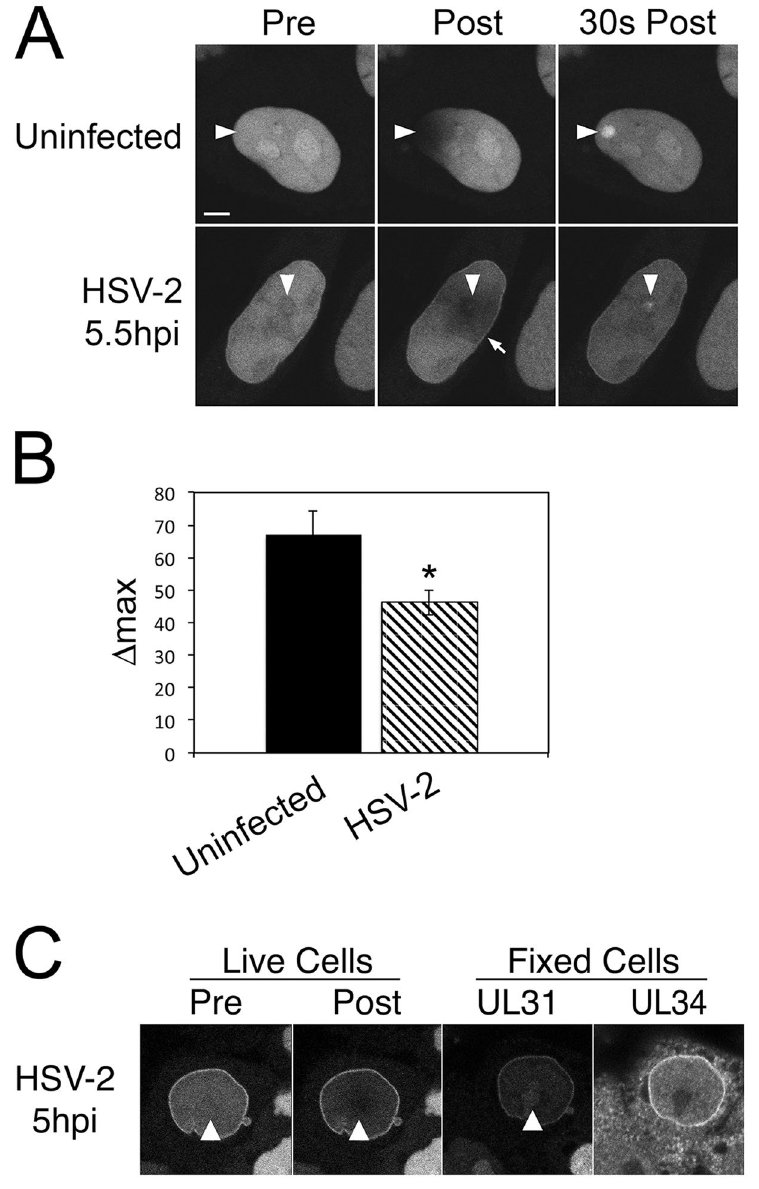
Figure 12. UL31 is preferentially recruited to sites of laser microirradiation in HSV-2 infected cells. ( A ) HeLa/EGFP31 cells were either mock-infected (uninfected) or infected with HSV-2 at an MOI of 3 for 5.5 h prior to microirradiation and time lapse analysis. Representative images from time lapse experiments before irradiation (Pre), immediately after irradiation (Post) and 30 s post irradiation are shown. Arrowheads indicate sites of laser microirradiation. Arrow indicates concentration of EGFP-UL31 at the nuclear rim, a surrogate indicator of UL34 expression and virus infection. ( B ) Quantitative analysis of UL31 recruitment to sites of laser microirradiation. n = 19 for infected cells in two independent experiments, n = 5 for uninfected cells. Using an unpaired t test the Δ max of UL31 in uninfected HeLa/EGFP31 cells was compared to the Δ max of HSV-2 infected HeLa/EGFP31 cells ( * p < 0.05). ( C ) Images of a live HeLa/EGFP31 cell on a grid-bottom dish and infected with HSV-2 for 5 hours. Images taken immediately before (Pre), and immediately after (Post) the indicated area (white arrowhead) was microirradiated with a 405 nm laser using an Olympus FV1000 laser- scanning confocal microscope. Cells were immediately fixed and stained with anti-UL31 antibody followed by staining with Alexa 568 conjugated donkey anti-chicken secondary antibody. Microirradiated cells were relocated and images captured by confocal microscopy (Fixed Cells). Image is representative of n = 8 cells analyzed in two independent